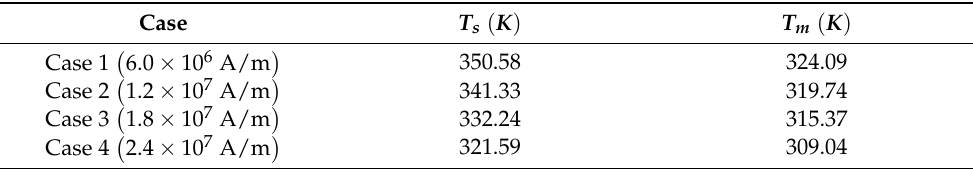
Figure 11. Temperature contours in the case of two VGs (Case D). Table 6. Temperature values in the case of two VGs (Case